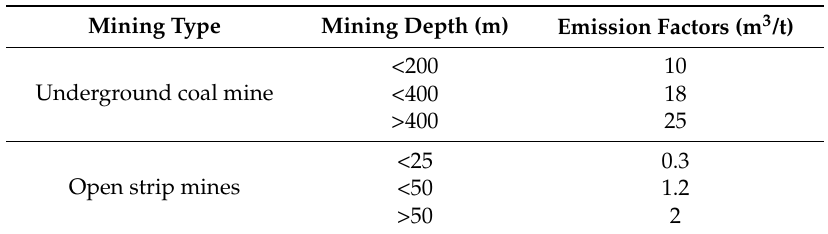
Table 1. The factors influencing carbon emissions in coal production.